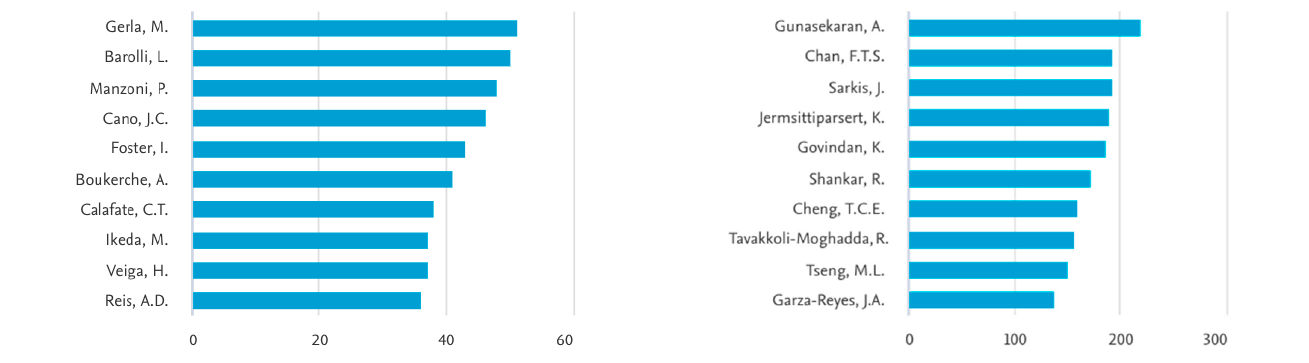
Table 3. Breakdown of the publication by author.